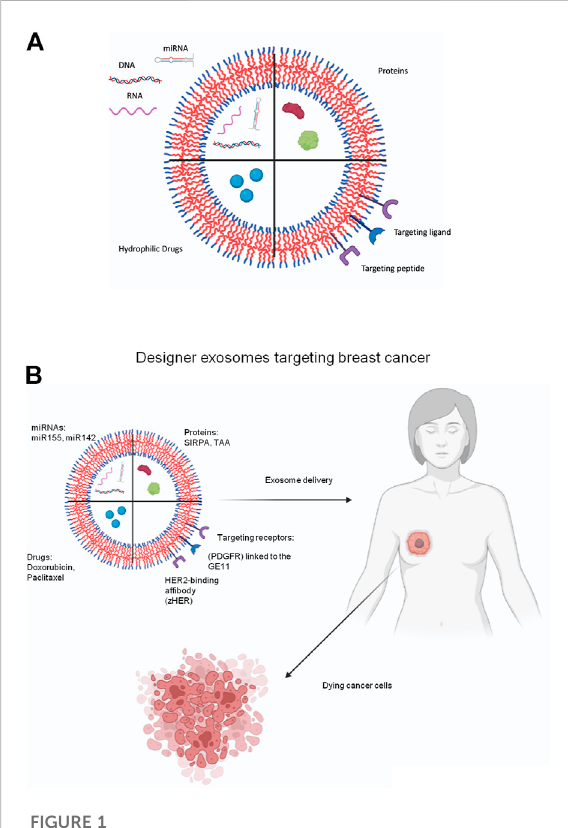
FIGURE 1 (A) Schematic representation of the different types exosome engineering approaches. Different therapeutic molecules can be either loaded into lumen or displayed on the exosome surface for clinical purposes. Various DNA, RNA, miRNA molecules can be packaged or various protein molecules. Targeting ligands or targeting peptides can be displayed on the surface. Various anti- cancer drugs can loaded into the exosomes. (B) Schematic diagram showing treatment of breast cancer using designer exosomes. Exosomal cargo such as miRNA, protein, drugs can